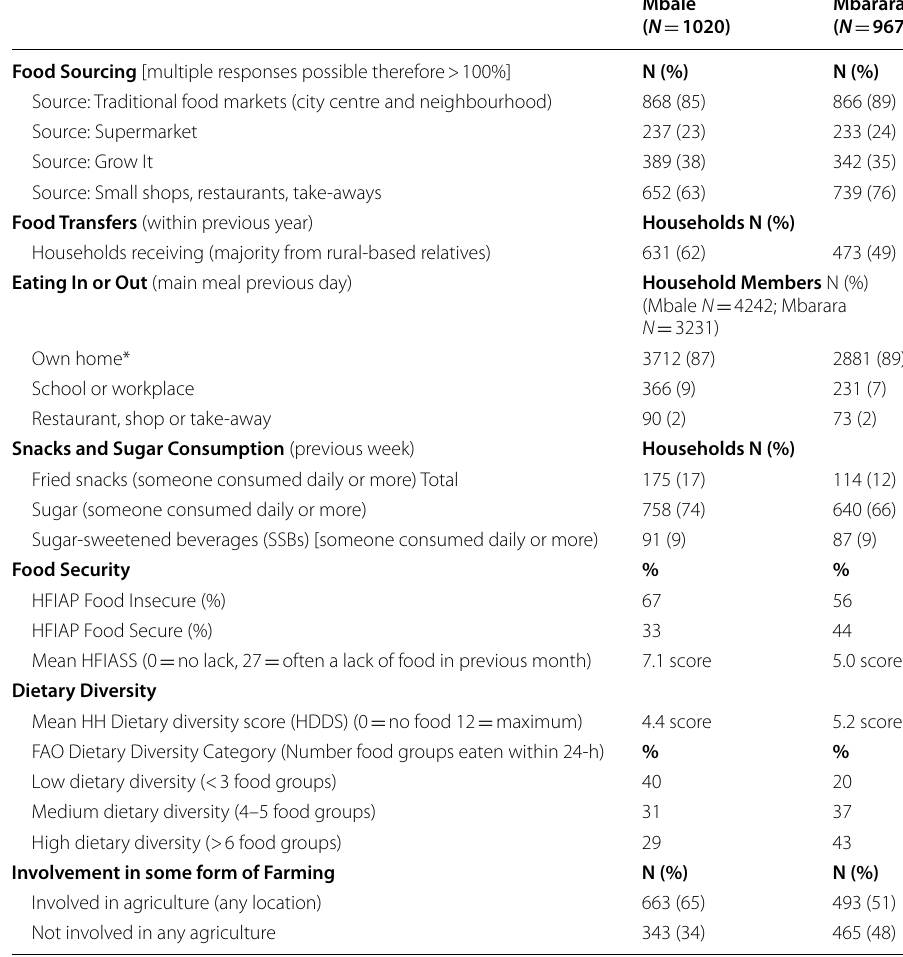
Table 1 Household Food Environment and Involvement in